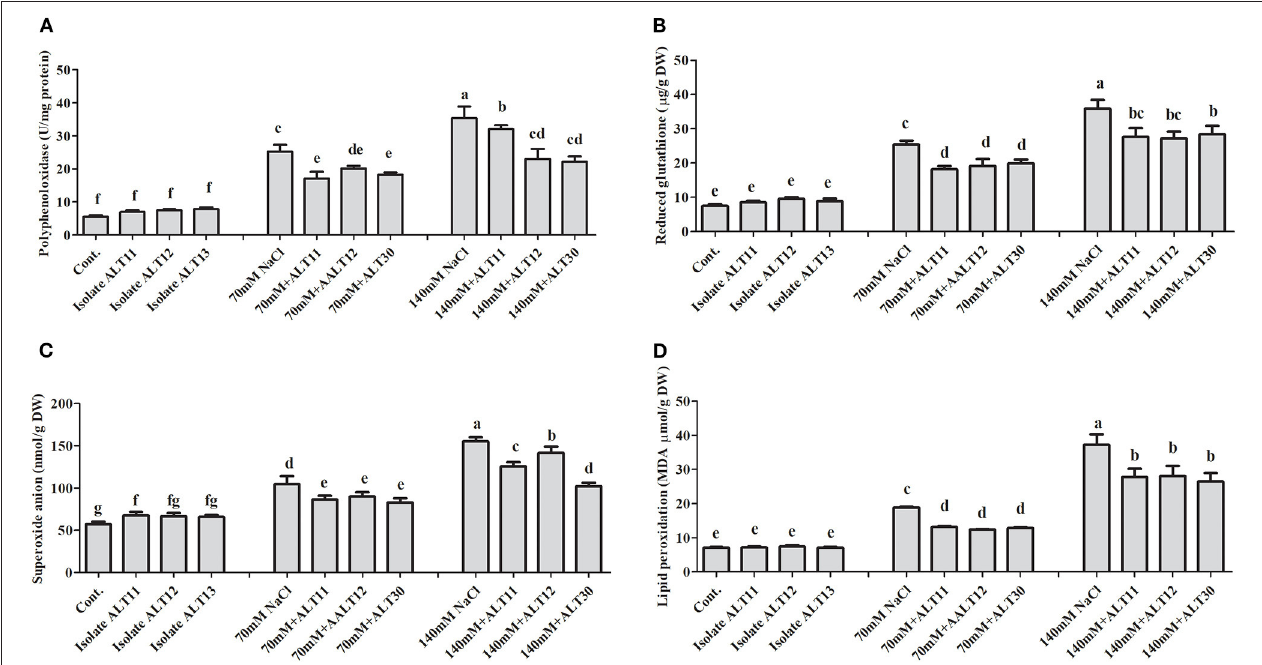
FIGURE 4 | The effect of isolates ALT11, ALT12, and ALT30 on different antioxidants under normal conditions and NaCl stress (70 and 140mM). (A) Polyphenol oxidase (PPO); (B) reduced glutathione (GSH); (C) superoxide anions (SOAs); (D) lipid peroxidation (MDA). Different letters indicate significant differences between the mean values of the three replicates ± standard